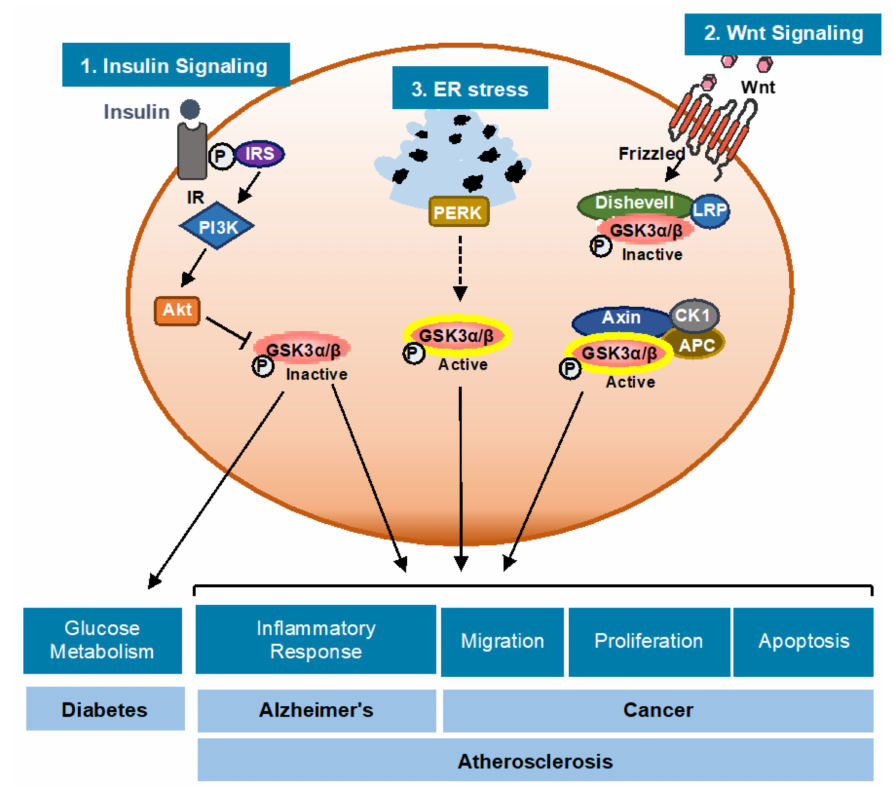
Figure 2. GSK3 α / β : regulation, cellular functions and diseases. Three cellular signaling pathways are directly involved in GSK3 α / β regulation: (1) insulin binds to the insulin receptor and activates the PI3-Akt pathway leading to GSK3 α / β inhibition; (2) endoplasmic reticulum stress (ER stress) signaling and/or unfolded protein response (UPR) activation promotes the activation of GSK3 α / β through the endoplasmic reticulum kinase (PERK) pathway; and (3) Wnt ligands bind to the Frizzled receptor and induces the formation of a complex of the scaffold protein axin, APC, CK1 and the kinase Dishevelled, which phosphorylates and inactivates GSK3 α / β . The complex interplay between these pathways regulates the network of signaling pathways that modulate cell viability and metabolism.